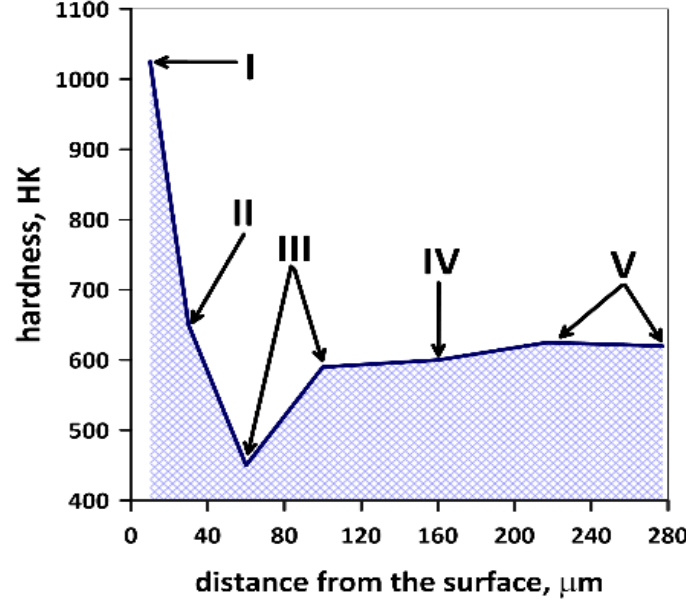
Figure 7. Changes in hardness as a function of the distance from the die insert surface.